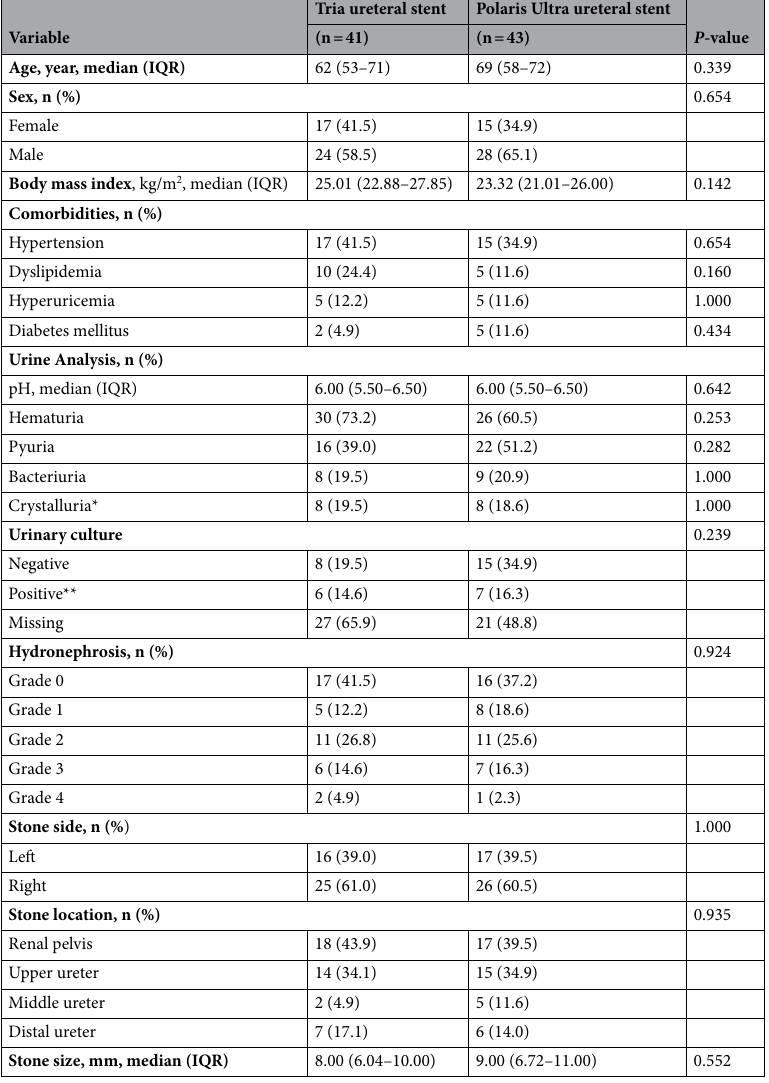
Table 1. Baseline characteristics of the study cohort. IQR interquartile range. *Calcium oxalate (n = 12), uric acid (n = 2 ), both (n = 1), and calcium phosphate (n = 1). **Coagulase-negative Staphylococcus (n =